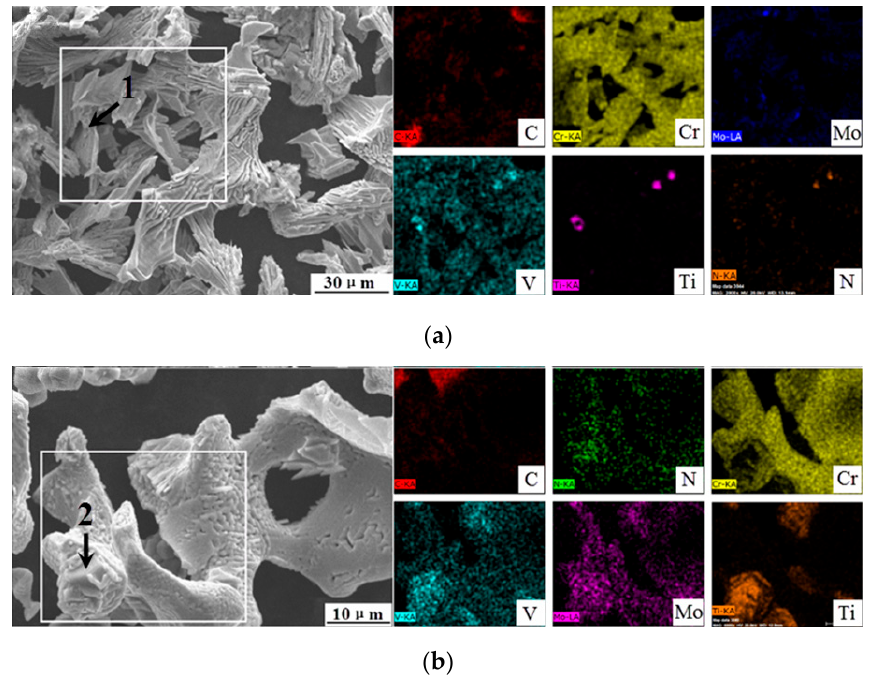
Table 3. EDS ‐ analyzed results of carbides containing chromium (mass %). Sample No.